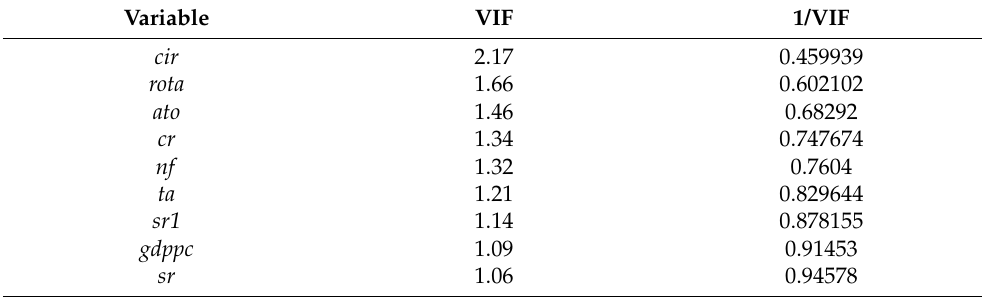
Table 6. Multicollinearity test.